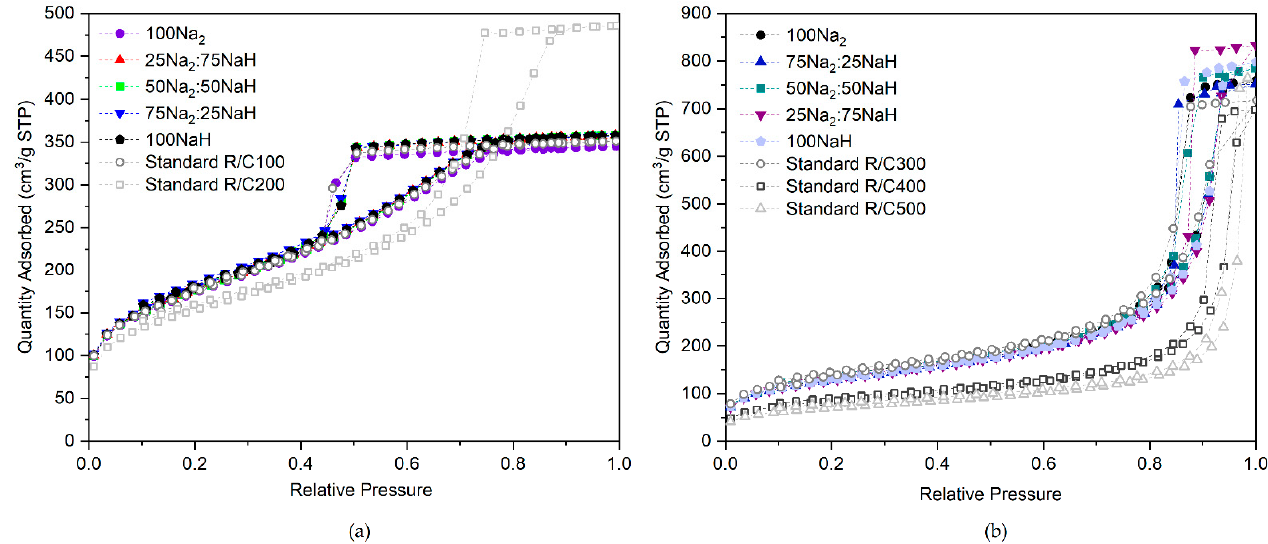
Figure 4. ( a ) Isotherms from sample set 1 (i) Na 2 /NaH R/C100 Na + equivalent, ( b ) sample set 1 (ii) Na 2 /NaH R/C300 Na + equivalent. Note that R/C is the resorcinol/catalyst molar ratio.